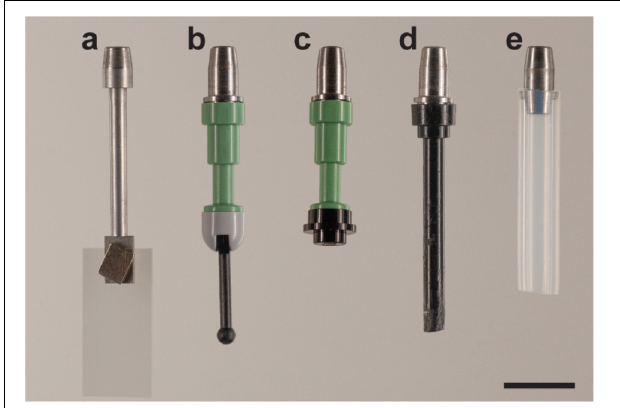
FIGURE 3 | Adapters for the sliding rod holder. The versatility of the holder stems from the fact that different adapters can be used. Five different adapters are shown here: (a) cover slip adapter; LEGO adapters with various geometries, (b) LEGO Mini fig Telescope (64644) and LEGO Base with Black Lever (73587), (c) LEGO Mini fig Telescope (64644) and LEGO Round Plate 1 × 1 (4073/6141/15570); (d) LEGO Antenna 1 × 4 with Rounded Top (3957/15609/30064) and (e) FEP tube adapter with 4.0 × 6.0 mm FEP tube (Maagtechnic AG, ref. 10374302). Scale bar: 1